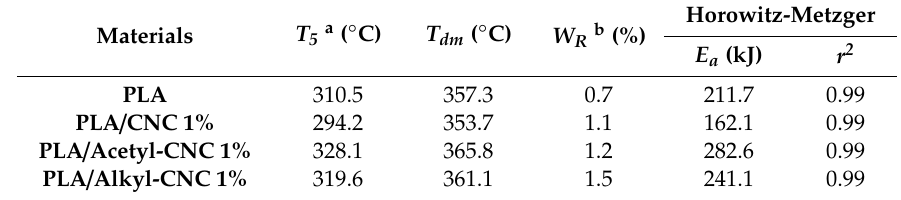
Figure 5. TGA thermograms ( a ) and DTG curves ( b ) of the neat PLA and the PLA nanocomposite. Table 3. Thermal degradation parameters and activation energy of the neat PLA and PLA nanocomposites.